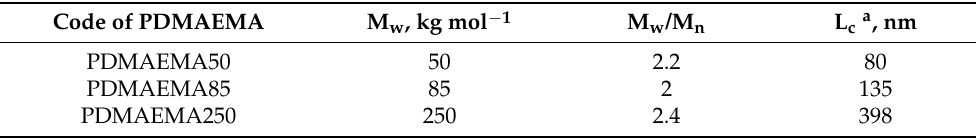
Table 1. PDMAEMA used in the synthesis of semi-IPN cryogels. Code of